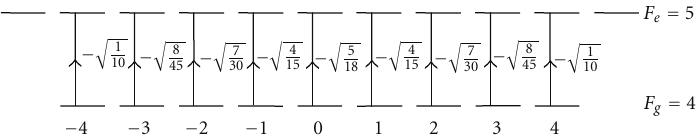
Figure 7: Clebsch-Gordon coe ffi cients describing the transition probabilities between Zeeman sublevels of the ground and excited levels of the F g = 4 → F e = 5 transition for linear polarization of the laser light [8].